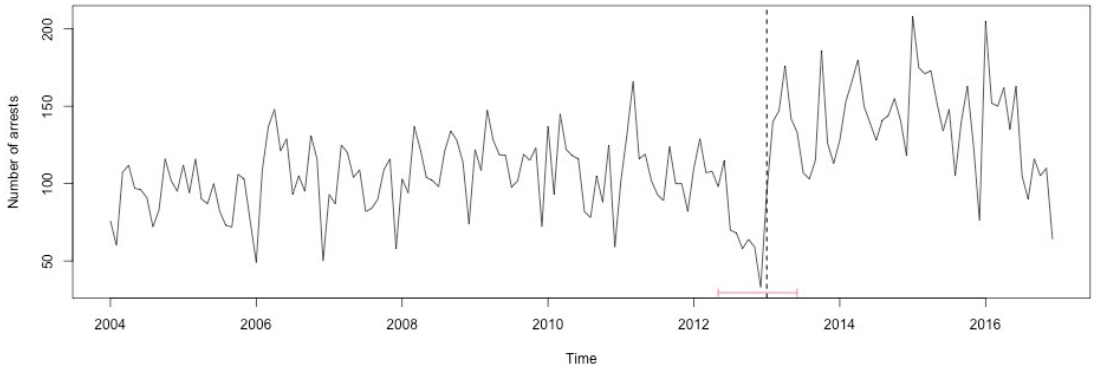
Figure A27. Methamphetamine Czech nationals arrests 2004–2016 in the Czech Republic and structural breaks.